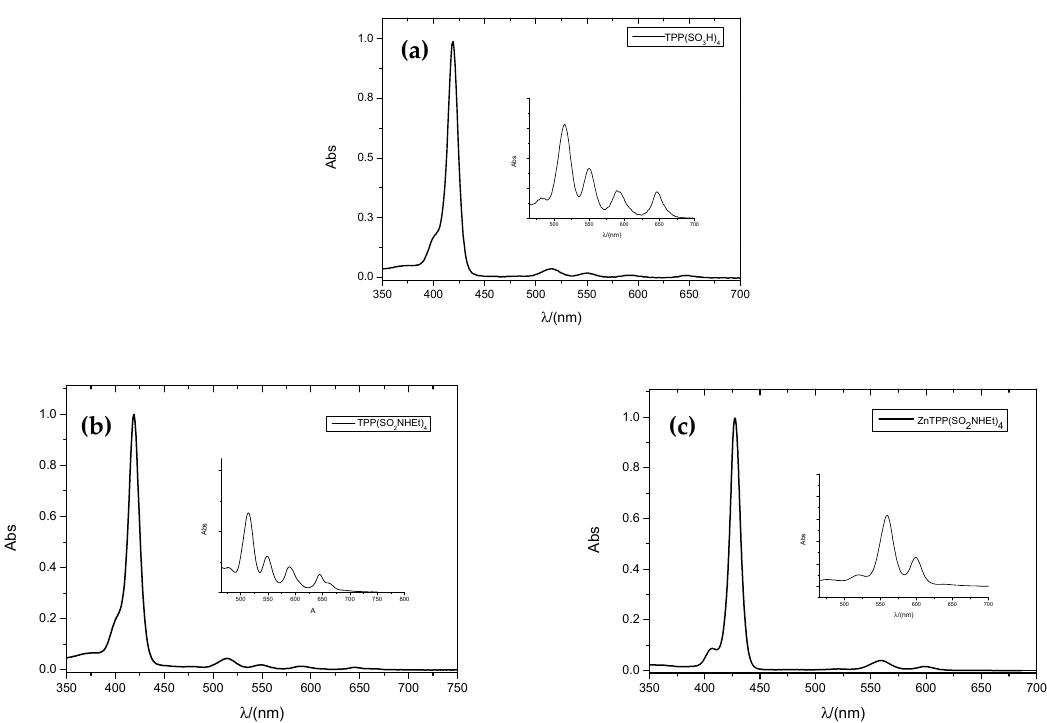
Figure 1. Normalized UV-Vis absorption spectra and respective Q-band magnifications of porphyrins ( a ) TPP(SO 3 H) 4 , ( b ) TPP(SO 2 NHEt) 4, and ( c ) ZnTPP(SO 2 NHEt) 4 in DMF.